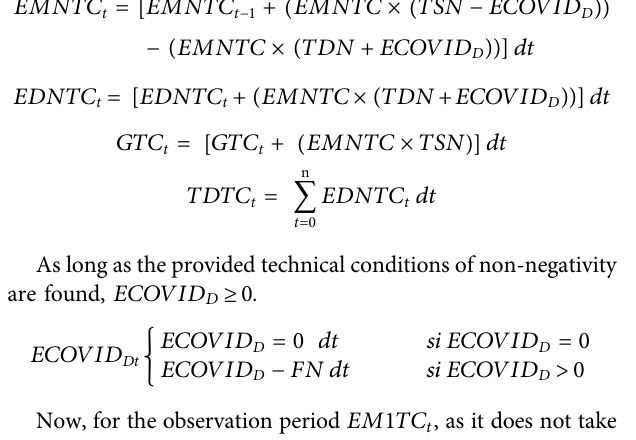
TABLE 1 | Computer simulations. Code Simulation SIM-1 Baseline behaviour of the model with initial parameters